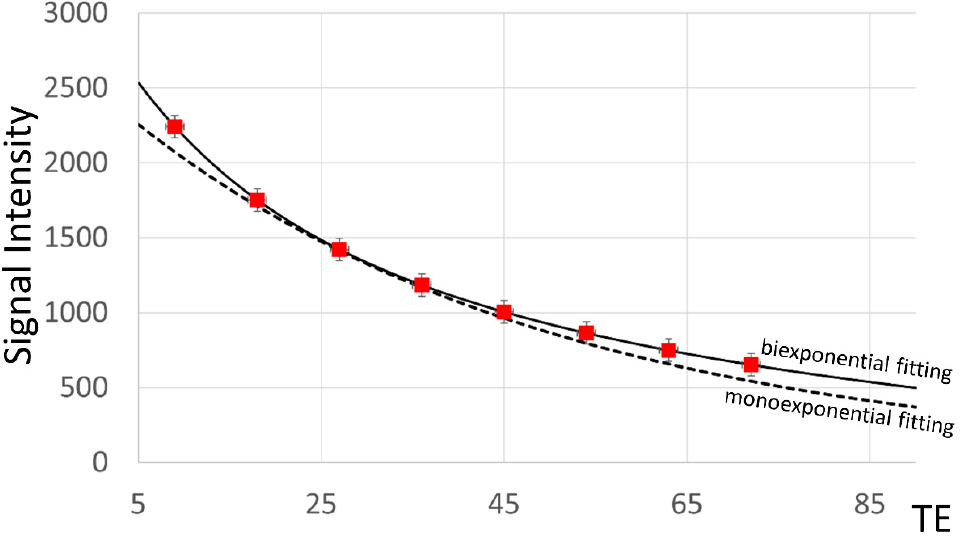
Figure 3. Signal-to-TE dependency for MRI examinations of the average signal of a single study from an automatically segmented AT region, proving that the signal is sufficient for biexponential fitting (solid line). In comparison, a monoexponential fitting result (dashed line) is presented, and it displayed a larger error of fit. Data points are marked in red.